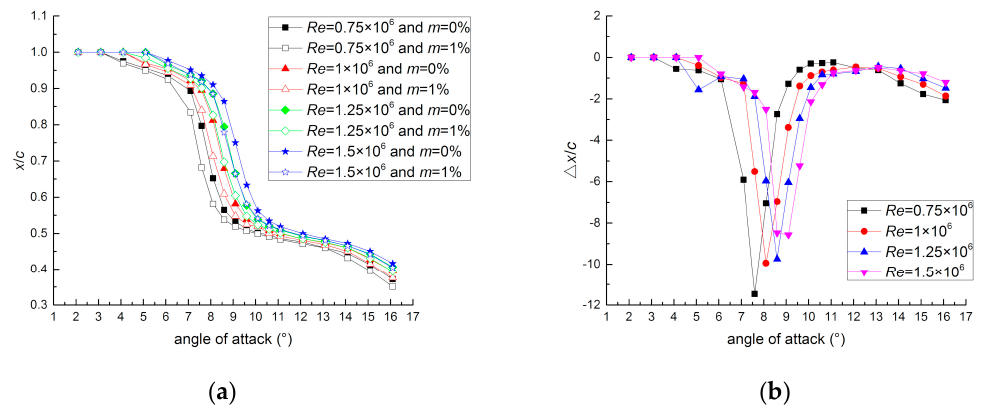
Figure 8. Re effects on location and moving distance of separation point on S809 airfoil: ( a ) Location of separation point; ( b ) moving distance of separation point.